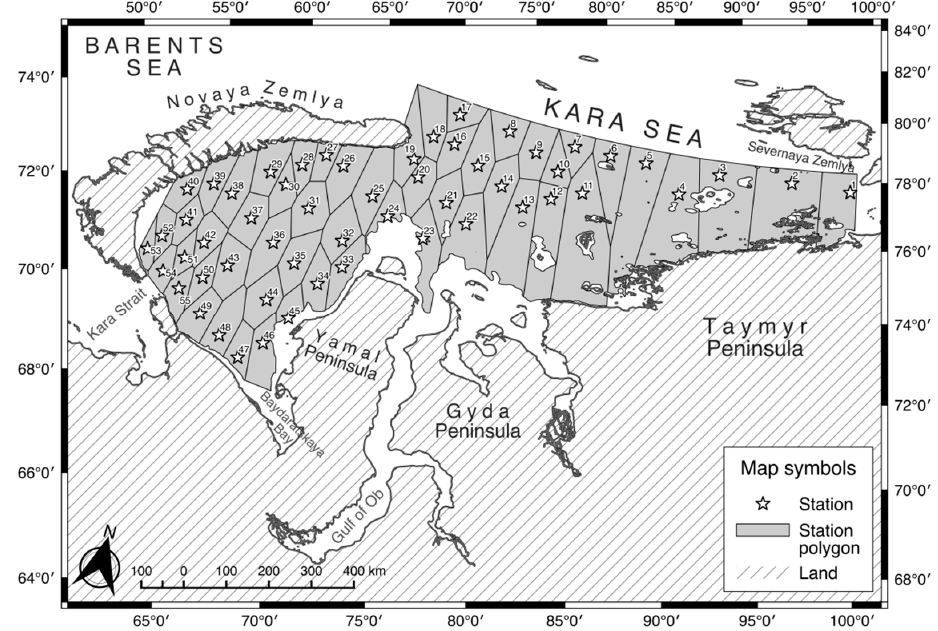
Figure 1. The study area of RV “Professor Levanidov” in the Kara Sea, September 2019. Table 1. Squares of polygons during September 2019 research survey in the Kara Sea. Station No. Area Surveyed, km 2